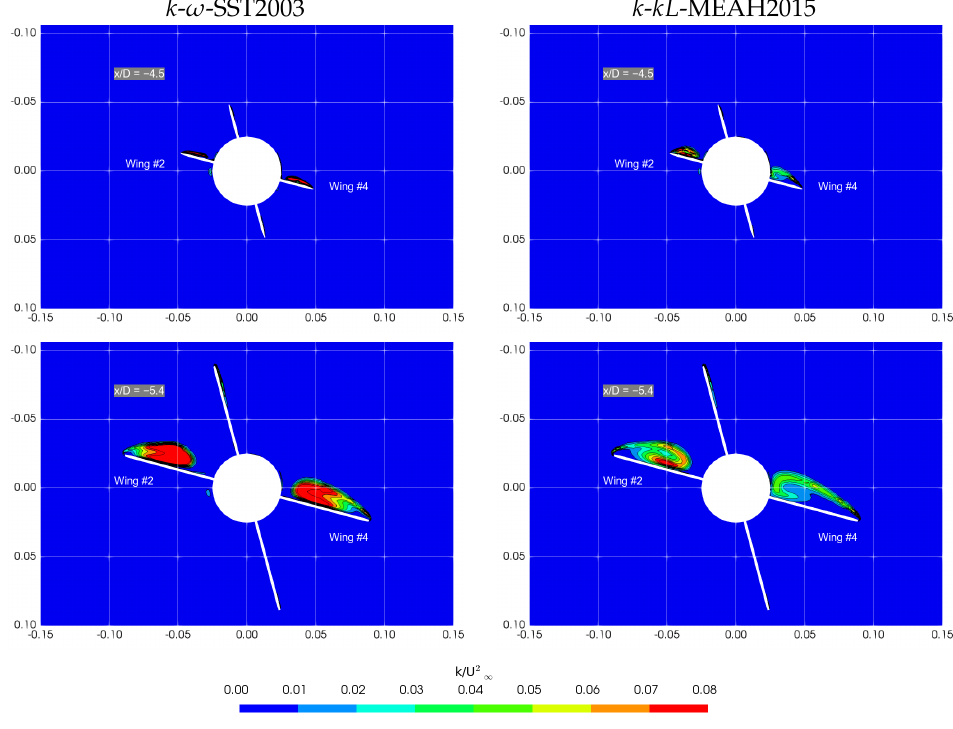
Figure 11. Normalized turbulent kinetic energy field in mid-wing transverse plane; M = 0.85, = 5 × 10 5 , λ = Re d Ref